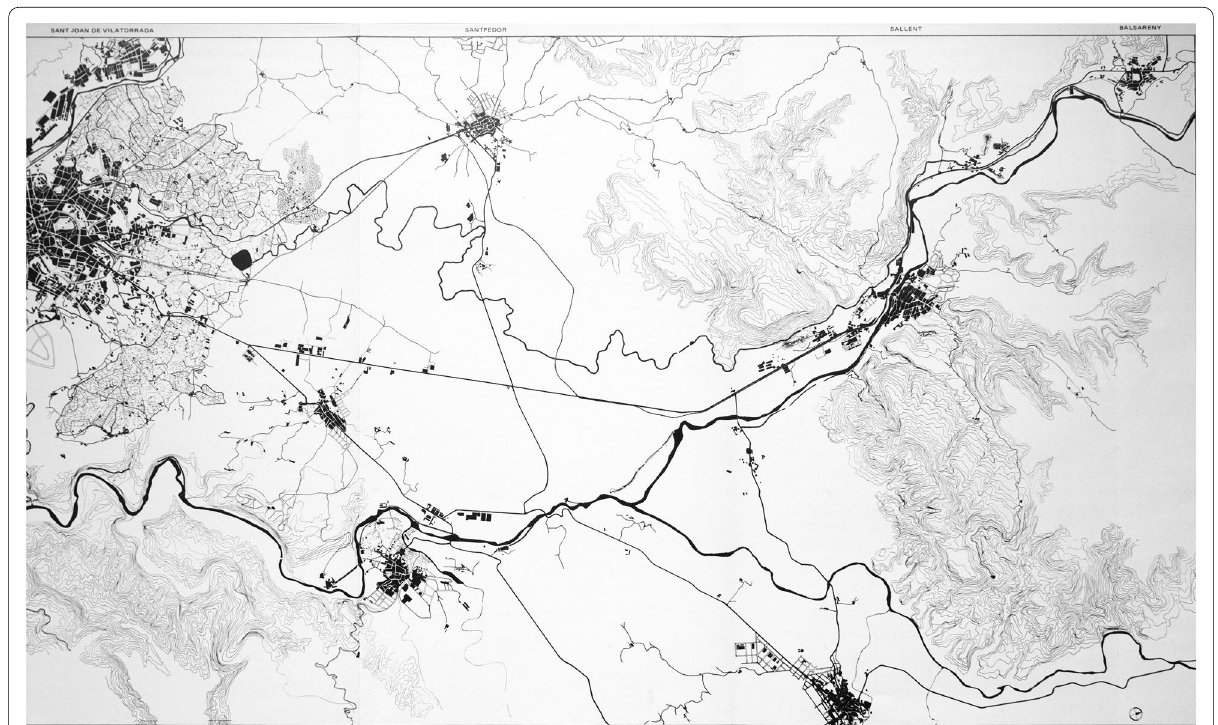
Fig. 3 Solà-Morales. ‘La forma d’un país’. El Bages. Original scale: 1/10.000. Drawn in 1976. Source: Solà-Morales M (ed) (1981c) Quaderns d’Arquitectura i Urbanisme Extra,